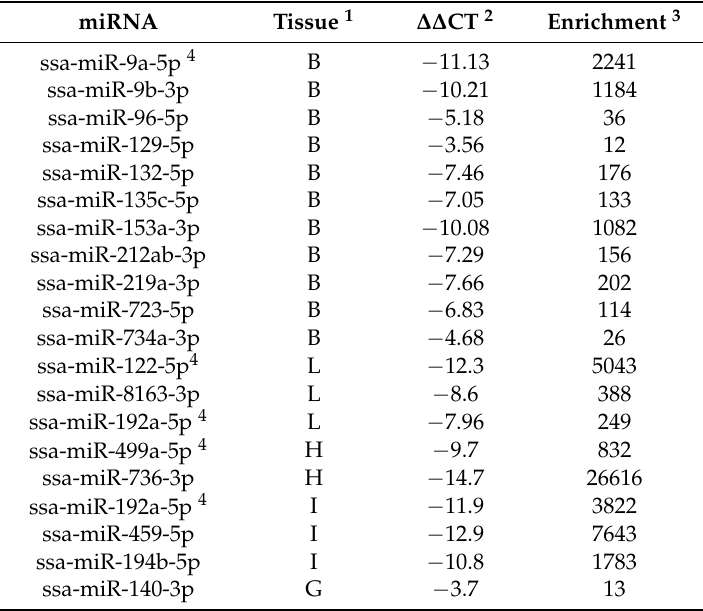
Table 3. Results from RT-qPCR